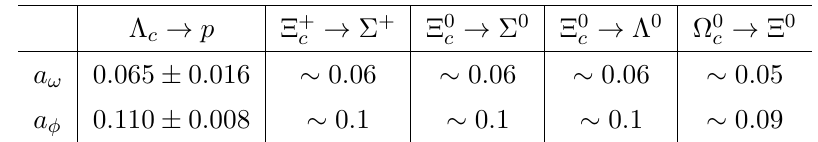
Table 1 . a ω , a φ parameters for various rare charm baryon modes, see text for